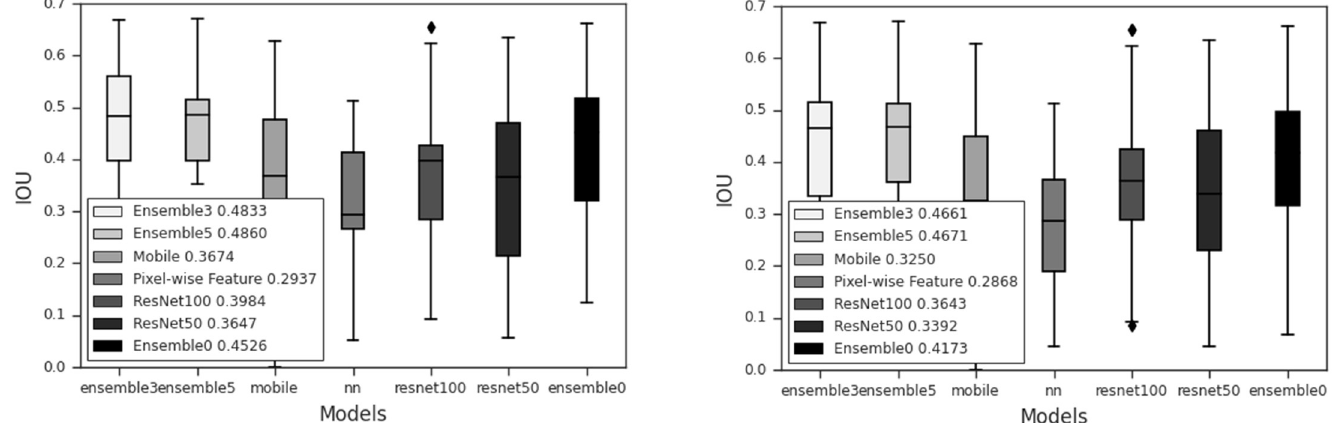
Fig 12. Box plots of IoU for MobileNet, hand-crafted feature map, ResNet101 and Resnet50. Ensemble model with 1, 3 and 5 extended output blocks. Each plot shows the median values. IoU of all model with (left) and without (right) post processing. https://doi.org/10.1371/journal.pone.0277573.g012 has them on the right. The accuracy of Ensemble3 and Ensemble5 without postproceessing is 91.01% and 91.18%. However with postproceessing Ensemble3 and Ensemble5 produce 87.50% and 91.72%. Therefore, for some cases when the postproceessing fails on some slices the increase of the size of the training block may improve the accuracy.